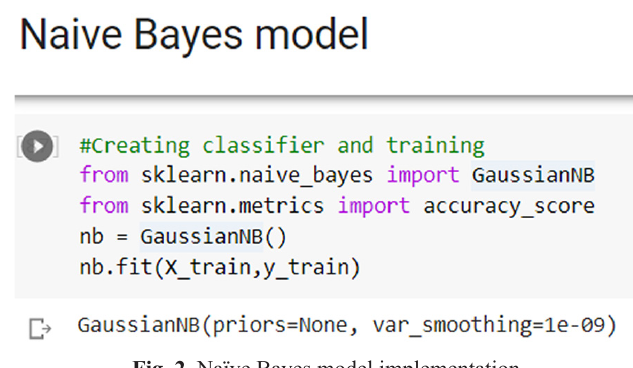
Fig. 2. Naïve Bayes model